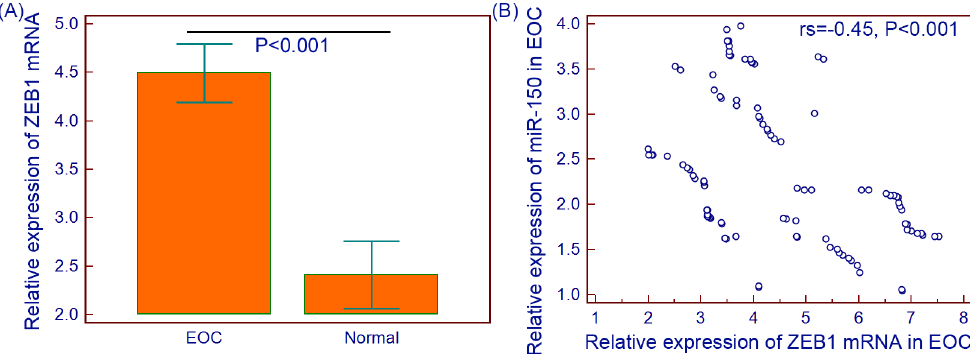
Figure 7. Expression levels of ZEB1 mRNA in 100 EOC tissue specimens and 10 normal ovarian tissue specimens were detected by qRT-PCR and normalized to b -actin. Expression level of ZEB1 mRNA in EOC tissues was significantly higher than that in normal ovarian tissues (EOC vs. Normal: 4.49 6 1.52 vs. 2.41 6 0.49, P , 0.001, A). More interestingly, the Spearman Correlation analysis clearly showed negative correlation between miR-150 and ZEB1 mRNA expression in EOC tissues (rs=–0.45, P , 0.001,